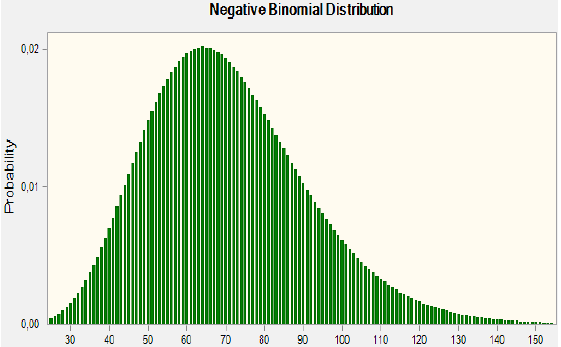
Figure 6. Probability distribution of the rental prices for a standard double-room in Košice.